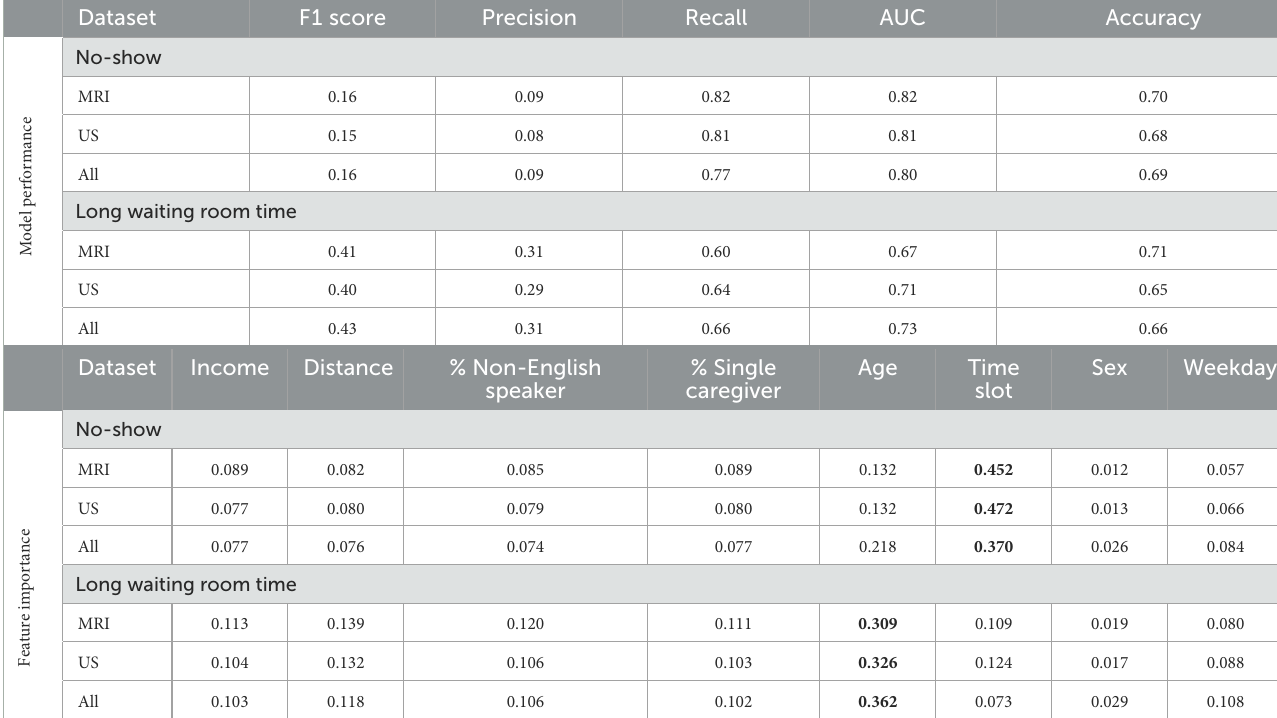
TABLE 4 Results for the predictive RF model. Dataset